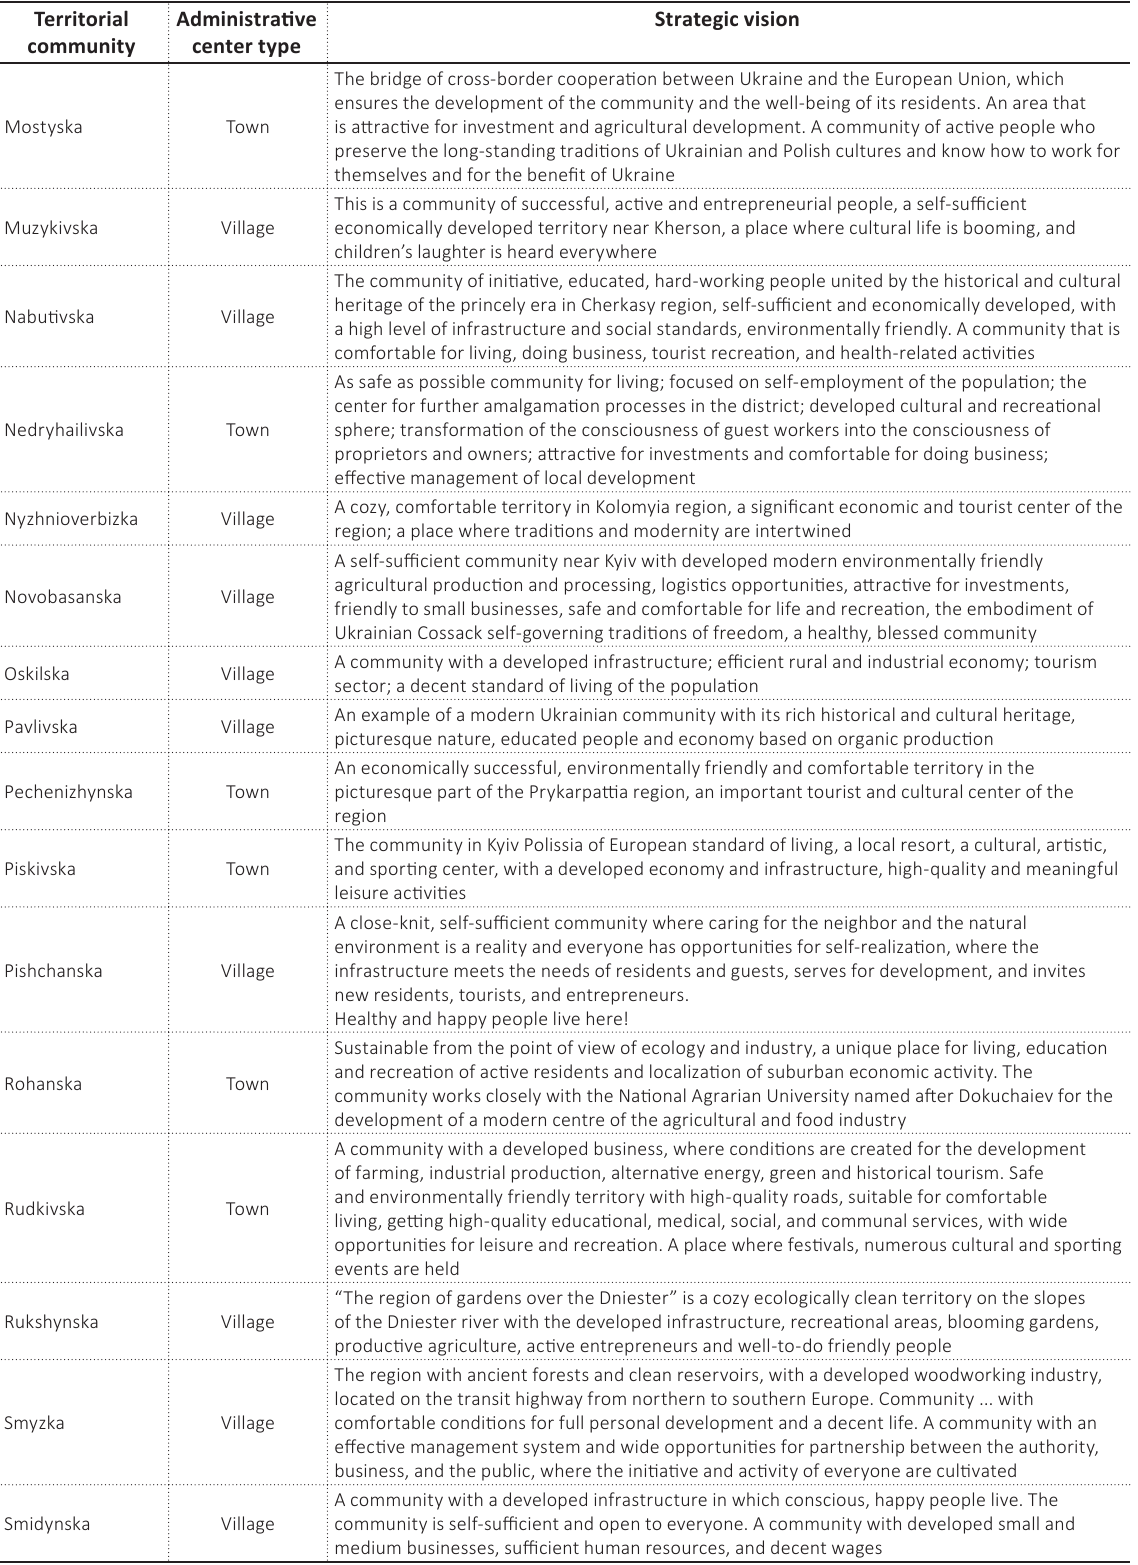
Table A1 (cont.). Strategic visions of the studied